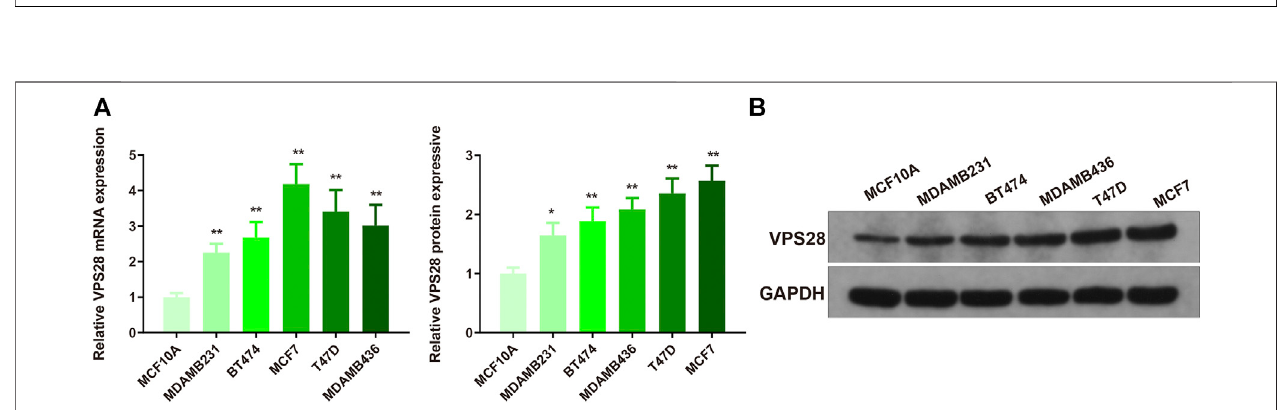
FIGURE3| VPS28 mRNA and protein expression levels in normal breast cell lineand breast cancercell lines. VPS28 mRNAand protein expression levels inMCF- 10A and breast cancer cells (MDAMB231, BT474, MCF7, T47D, and MDAMB436) determined by qRT-PCR and Western blotting (A , B) ; * p < 0.05, ** p < 0.01, n (cid:1) 3.